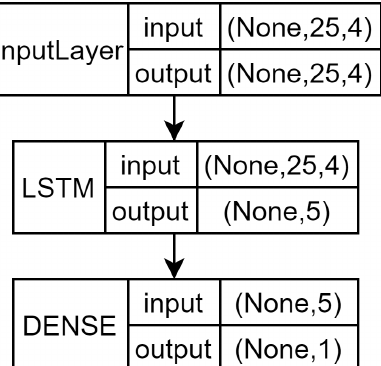
Figure A2. Mirshekarian’s architecture block diagram.